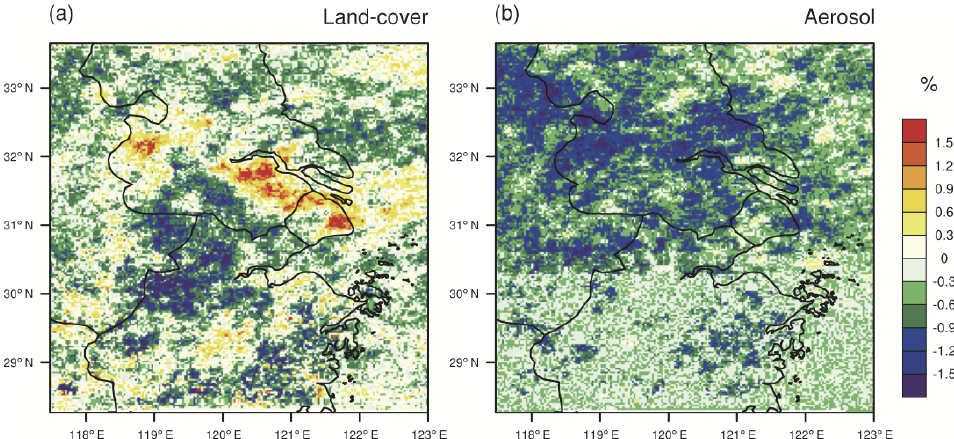
Figure 9. Differences in the frequency of summertime extreme rainfall events (averaged from 12:00 to 20:00LST) between simulations (a) LU06E70 and LU70E70 and (b) LU70E06 and